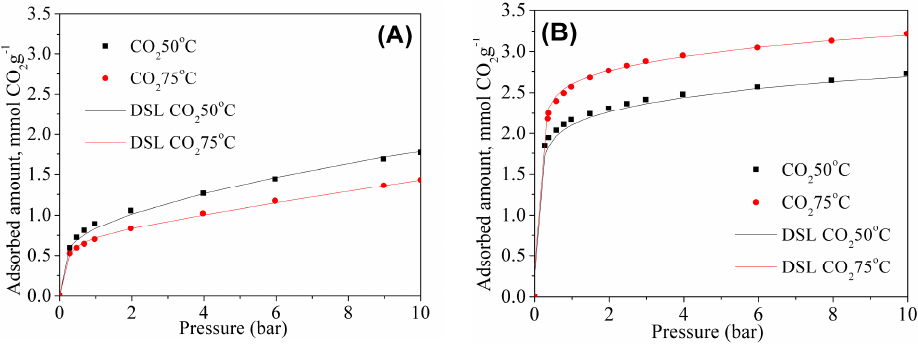
Figure 8. CO 2 isotherms for ( A ) MSG20 and ( B ) MSG20I30 samples.